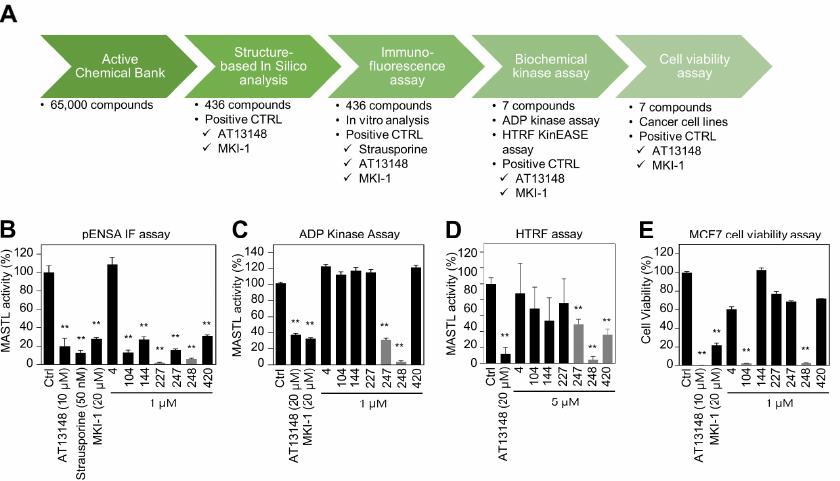
Figure 1. Identification of MASTL inhibitor MKI-2 using in silico and in vitro analyses ( A ) Schematic summary of in silico-based drug discovery process. Immunofluorescence ( B ), the ADP-Glo TM kinase assay ( C ) and HTRF kinase assay ( D ) were performed to determine MASTL activities under the treatments of two positive controls and candidate compounds. ( E ) MCF7 cells were treated with DMSO (Ctrl), 20 µ M AT13148, 20 µ M MKI-1, and 1 µ M candidate compounds for 72 h. Cell viability was measured using the WST-8 assay. The data are presented as the mean ± standard deviation of three independent experiments. ** p < 0.01.